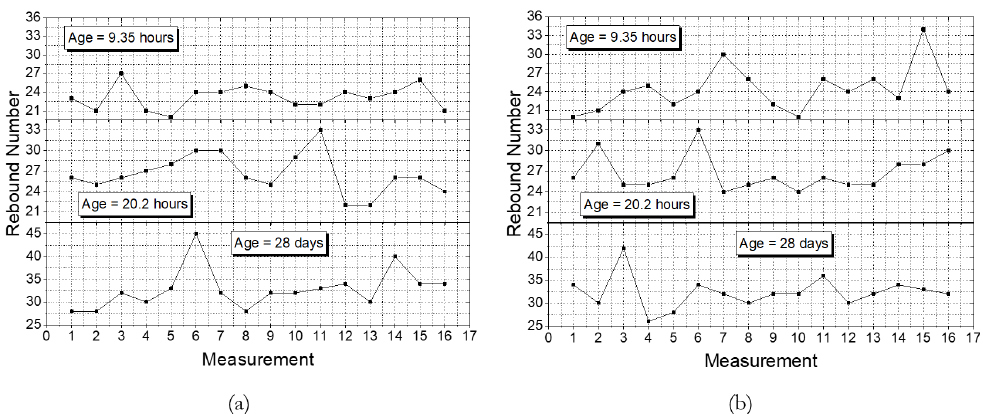
Figure 11 – Variation in the rebound number along the width of the hollow-core slab in the regions: (a) BW and (b) BR.